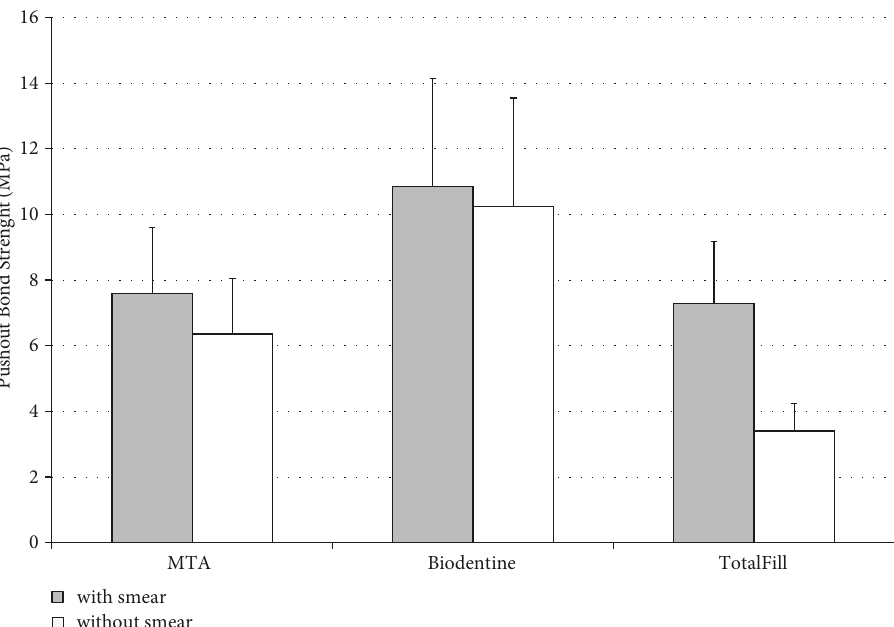
Figure 2: Means of the push-out bond strength (MPa) of the three materials tested with and without smear layer on the dentin surface (error bar represents SD). Table 2: Tukey Pairwise comparisons at 95% confidence intervals for the materials tested with the smear layer and without smear layer. Pairwise comparisons ∗ With a smear layer Without a smear layer Pairwise comparisons ∗ With vs. Without a smear layer MTA vs Biodentine S S MTA S MTA vs. TotalFill NS S Biodentine NS Biodentine vs. TotalFill S S TotalFill S